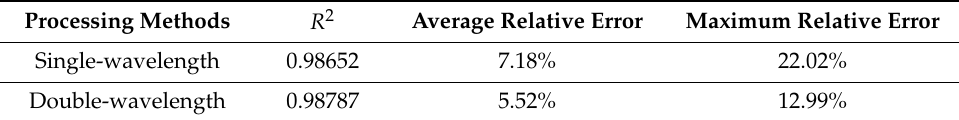
Table 7. Prediction results of double-wavelength method and single-wavelength method.